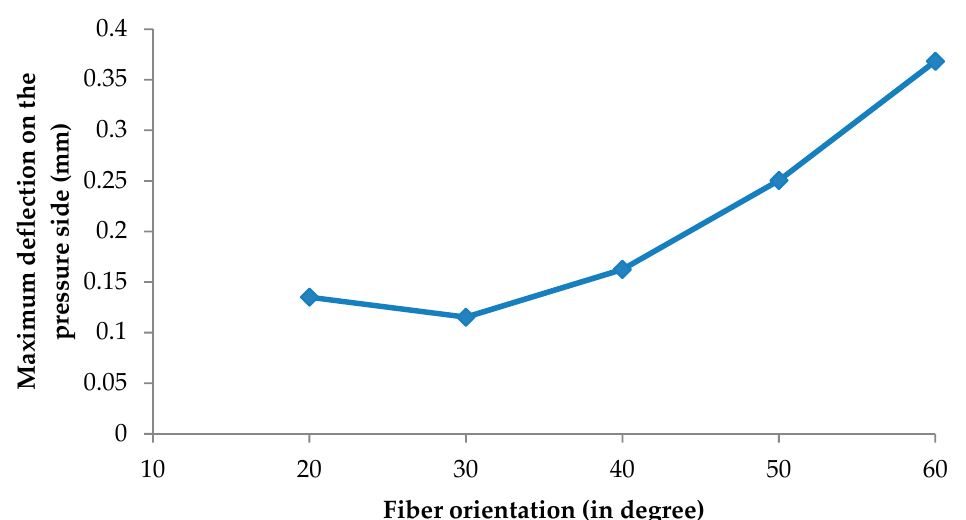
Figure 19. Effect of different fiber orientation on maximum deflection of the pressure side blade.